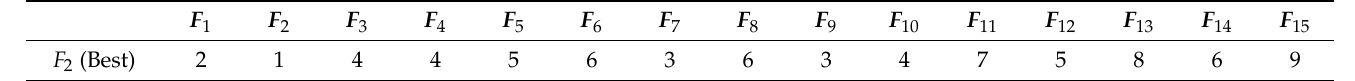
Table 11. The comparison between the best to other criteria.